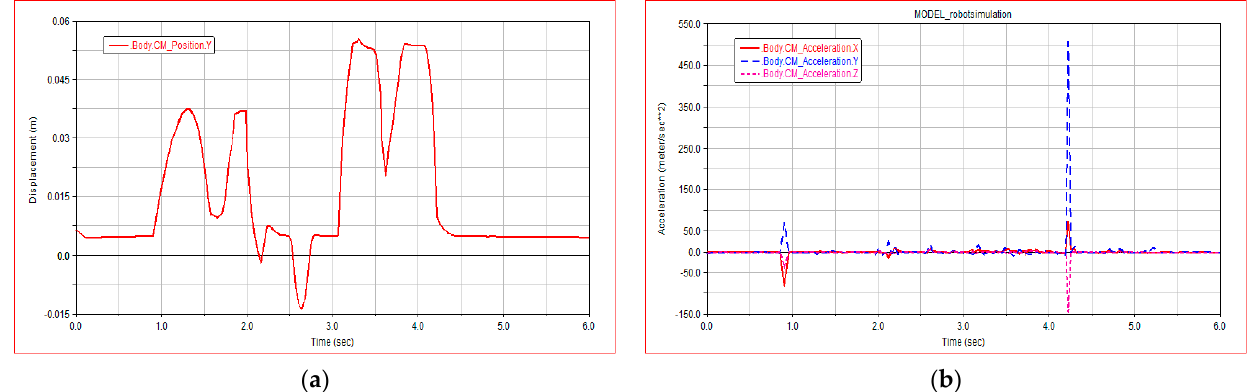
Figure 9. Simulation result diagram of crossing complex road surface: ( a ) robot centroid displacement; ( b ) robot centroid acceleration.